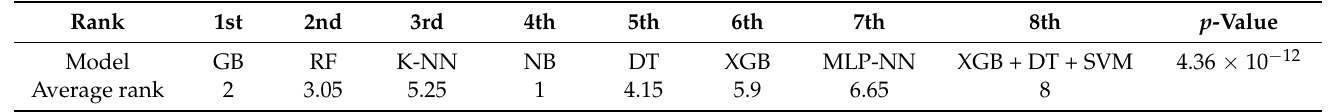
Table 8. Utilizing Friedman’s Rank test to determine each model’s mean rank position and p